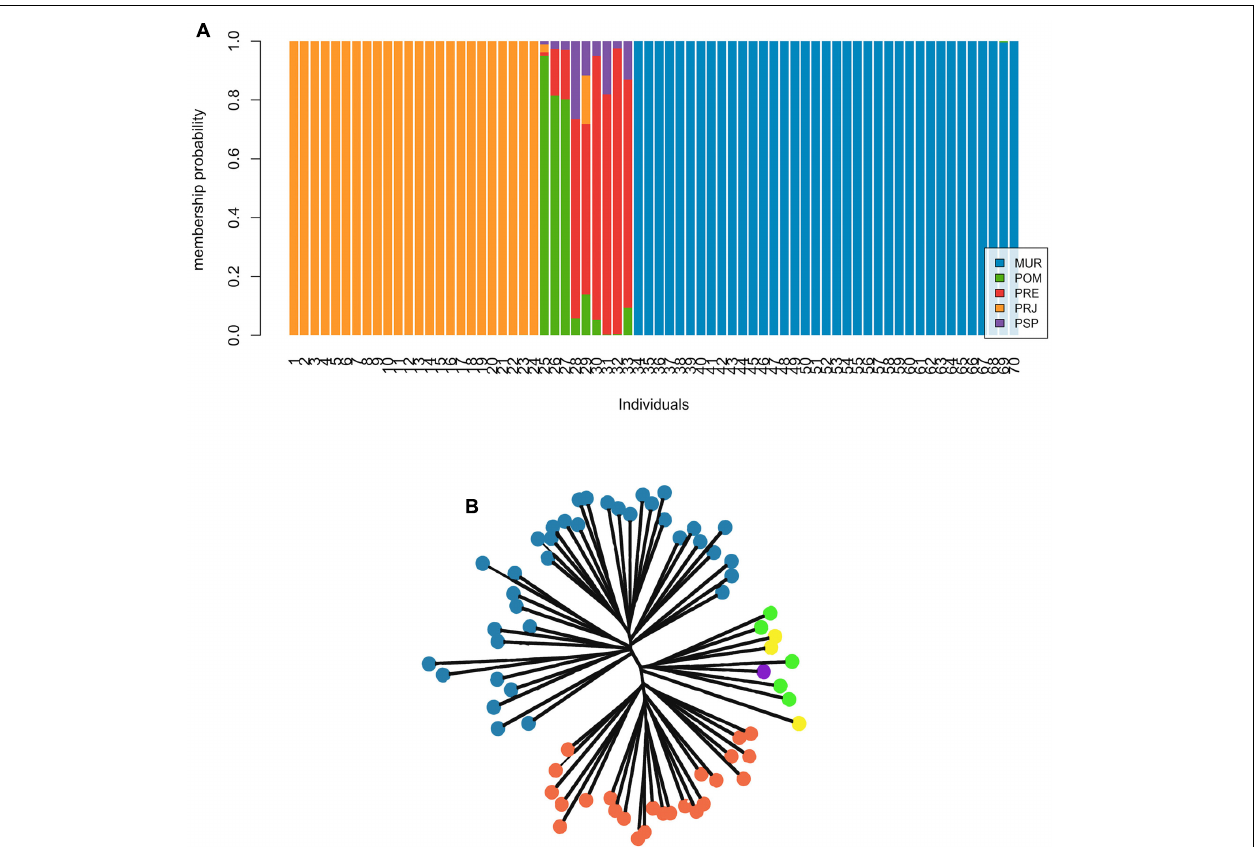
FIGURE 2 | Different individual assignment approaches in Steindachneridion parahybae . (A) Results of the Bayesian approach with the use of discriminant analysis of principal components (DAPC) to investigate genetic structure. The ideal number of major components found for the analysis was seven based on the α scoring trend. Each vertical bar represents an individual in the DAPC diagram and each color represents the probability of belonging to one of the genetic groups. (B) Unrooted tree from a Neighbor-joining analysis of distance data.